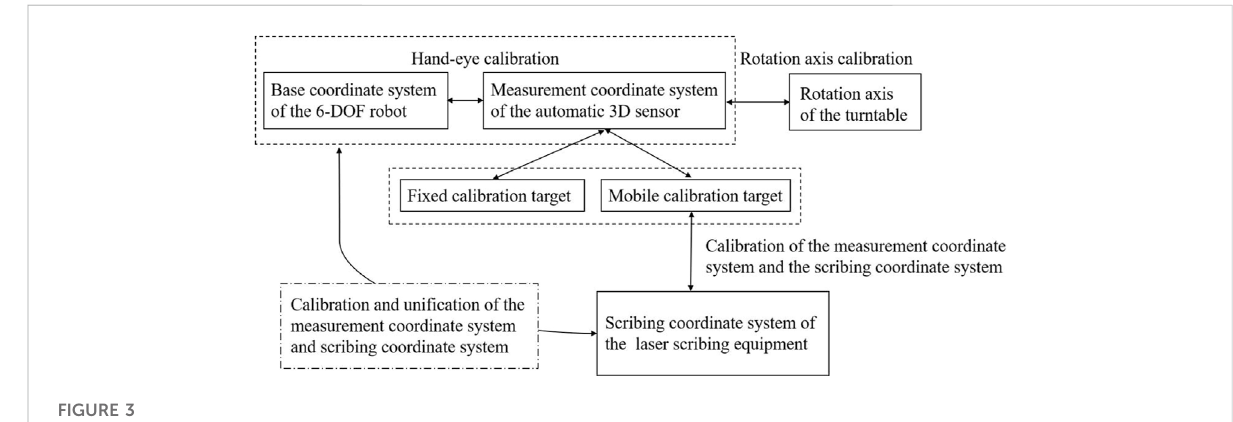
FIGURE 3 Multi-coordinate transformation.